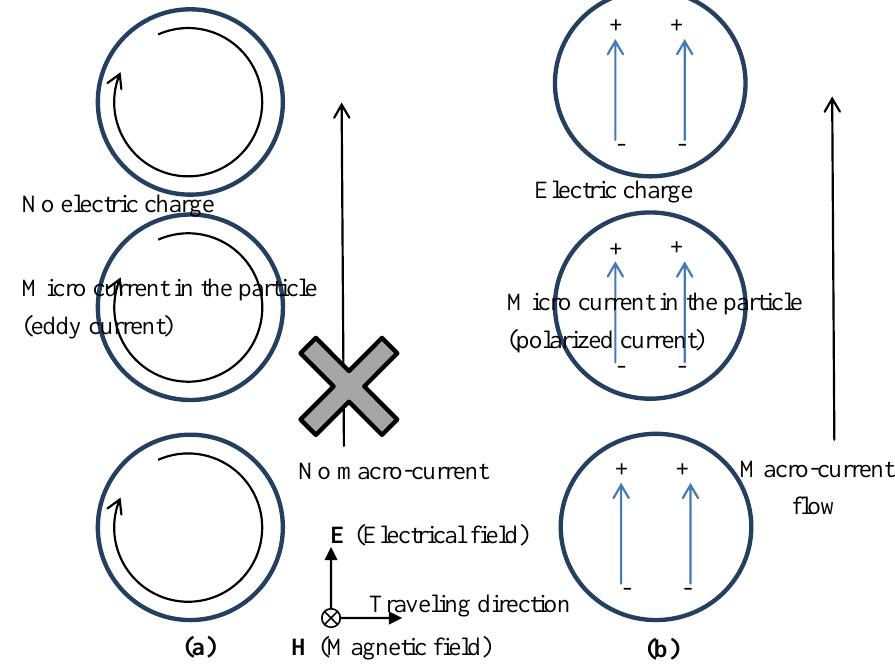
Figure 7. Current flow and electric charge distribution. ( a ) Large electrical conductivity such as metal. ( b ) Low electrical conductivity such as